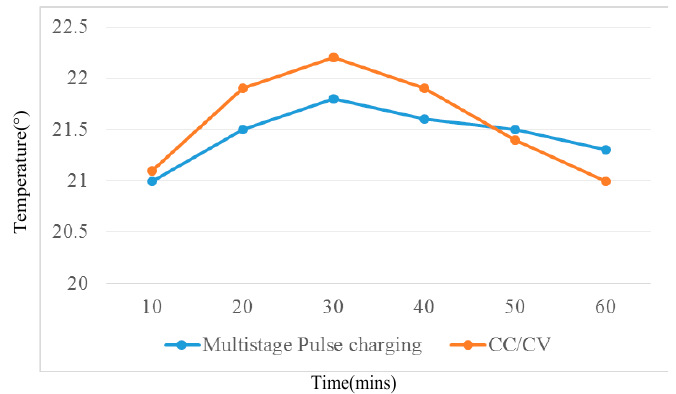
Figure 14. Measured temperature rise of a battery implementing both the proposed multistage pulse charging method and the constant current/constant voltage (CC/CV) method, respectively.